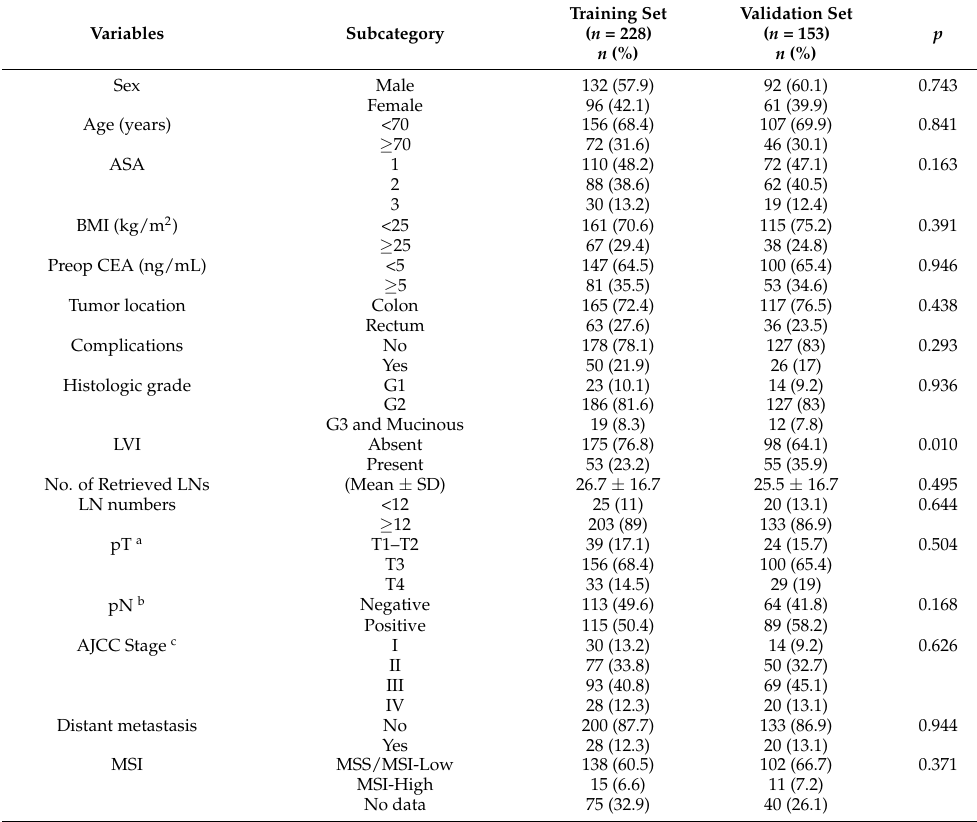
Table 1. Comparison of patients’ demographics between the training set and the validation